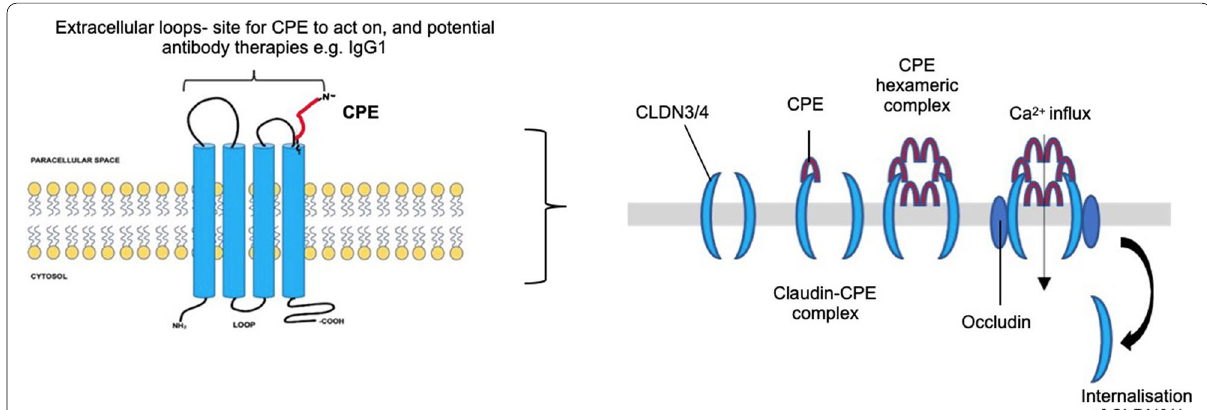
Fig. 4 Extracellular loops represent binding sites for anti‑CLDN3 antibodies, e.g., IgG1 [30] and CPE [32] (left). When CPE binds to CLDN3/4, a hexameric pore is made, compromising the cell membrane integrity. This leads to calcium ion influx and therefore cell death. The CPE‑claudin complex may also incorporate occludin, thereby further breaking the TJ [32]. CPE also has been found to internalise claudins [35], further increasing the membrane’s